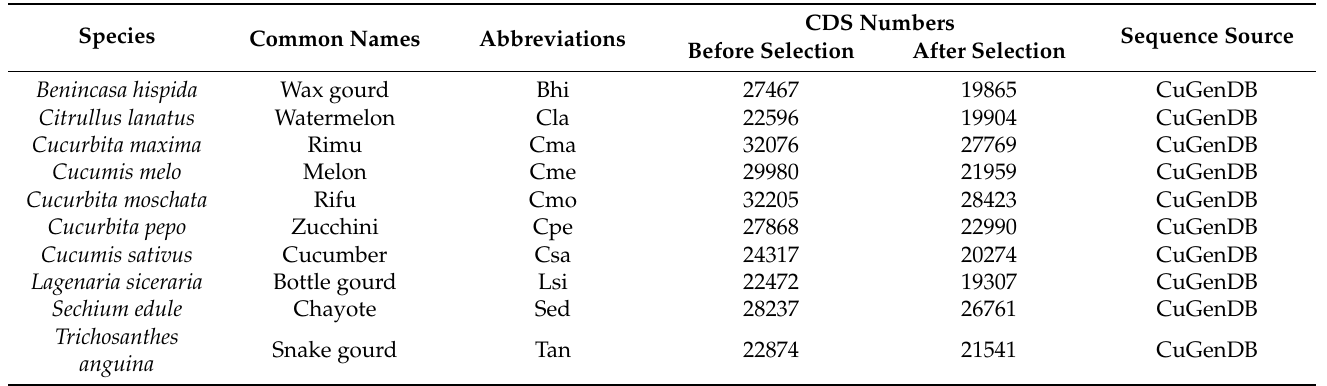
Table 1. Sequence information before and after selection in ten species of